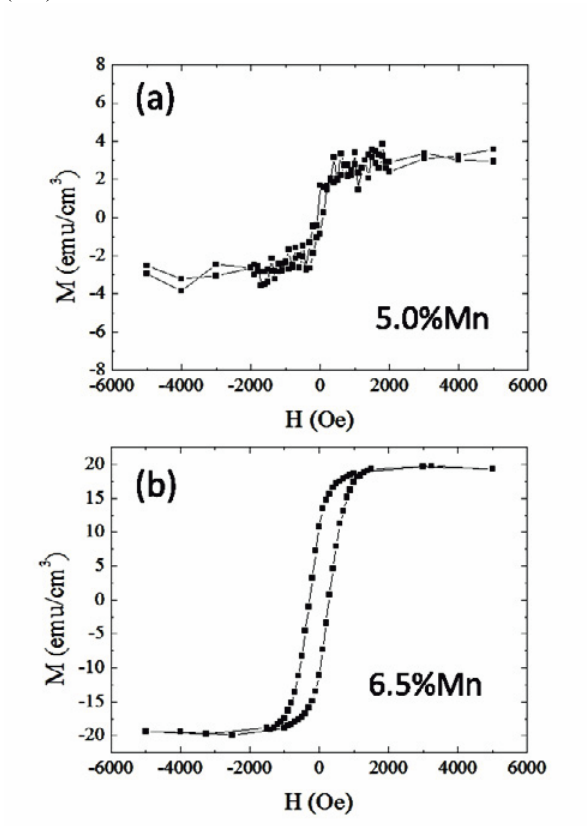
Figure 2. Magnetization as a function of applied field for (a) 5.0 % and (b) 6.5 % Mn-doped ZnSnAs 2 thin films at 300